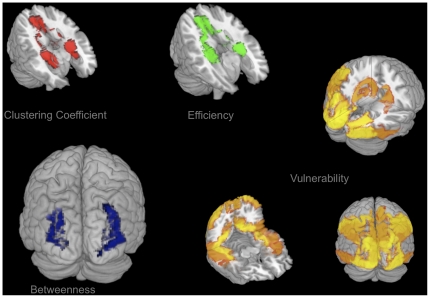
PC of graph theoretical metrics and perfusion for Group 1 and Group 2 for regionwise FDR (p<0.05).Corrected significant non-contradictory correlations (Spearman's rho) are visualised with colour intensity based on the absolute maxima of correlation magnitudes; PCs calculated with graph metrics from connectomes resulting from the sweep over plausible cortico-cortical sparsity levels (11–17% range). PC of local clustering coefficient and perfusion is negative (red, upper left), PC of local efficiency and perfusion is negative (green, upper middle), PC of local betweenness and perfusion is positive (blue, lower left), PC of local vulnerability and perfusion is positive (yellow, lower right).